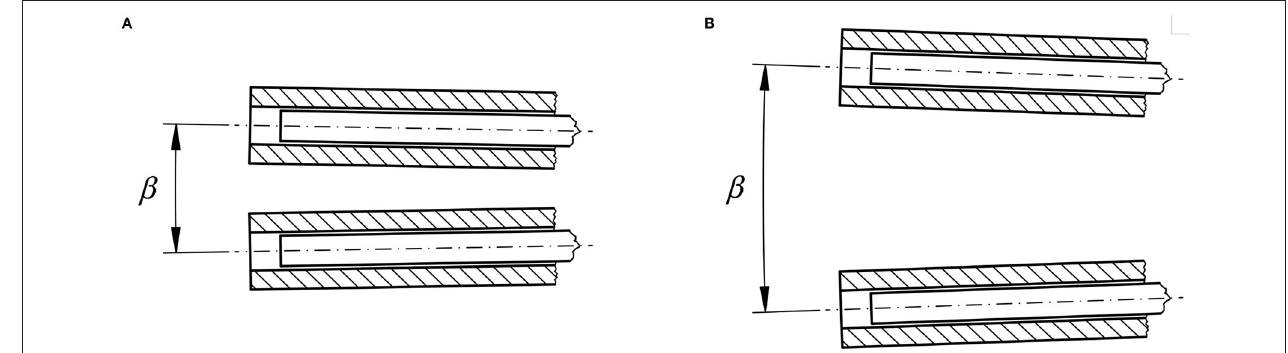
FIGURE 6 | Technically adjustable feature B: Zooming feature. The angle β between the axes of the single tubes can be varied. In (A) the angle β is small, comparable to a telephoto lens used in conventional photography. In (B) the angle β is larger, comparable to a wide-angle lens.